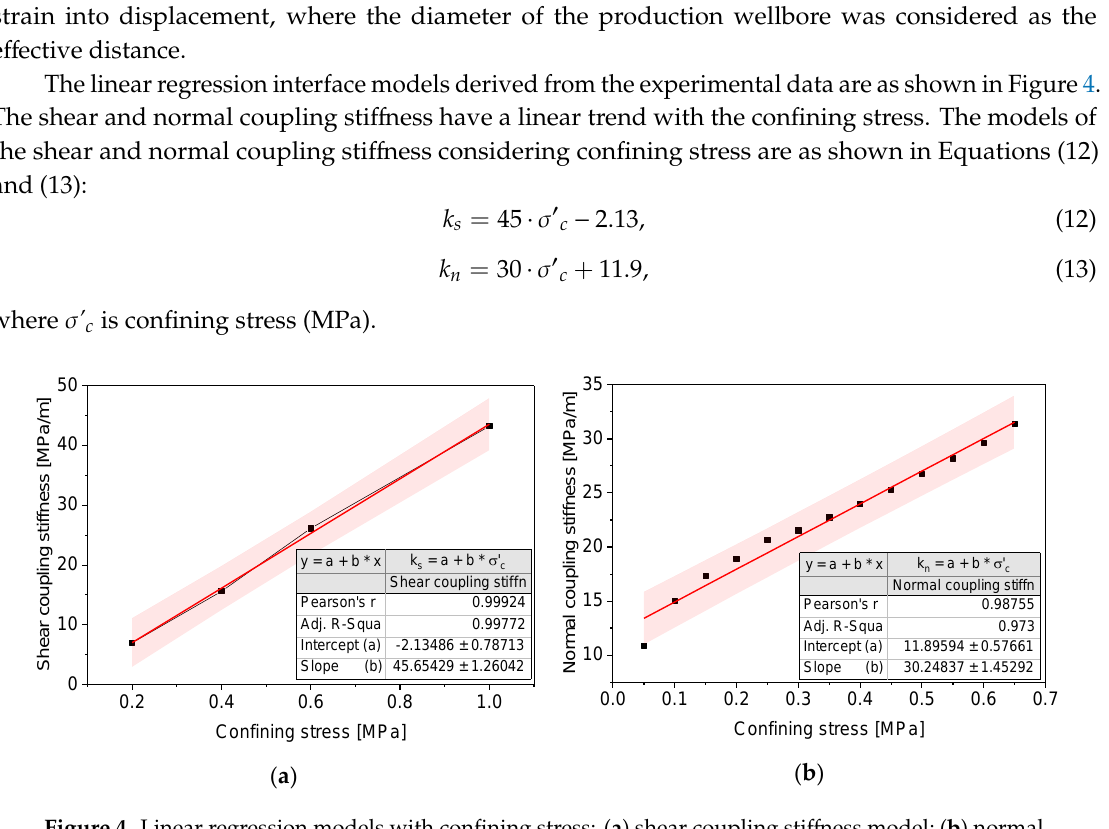
Figure 5. Comparison of interface stiffness models.